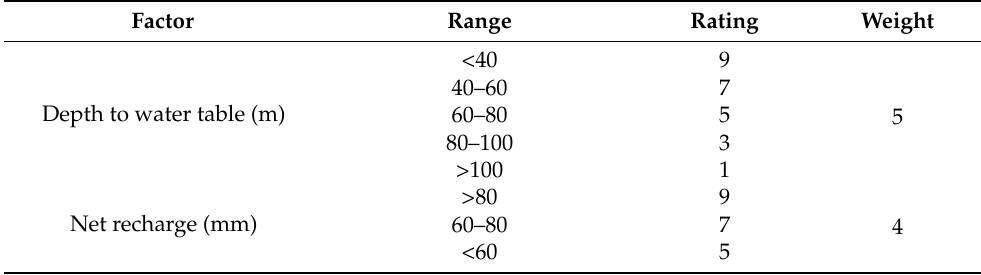
Table 2. Range, rating, and weights of all DRASTIC factors